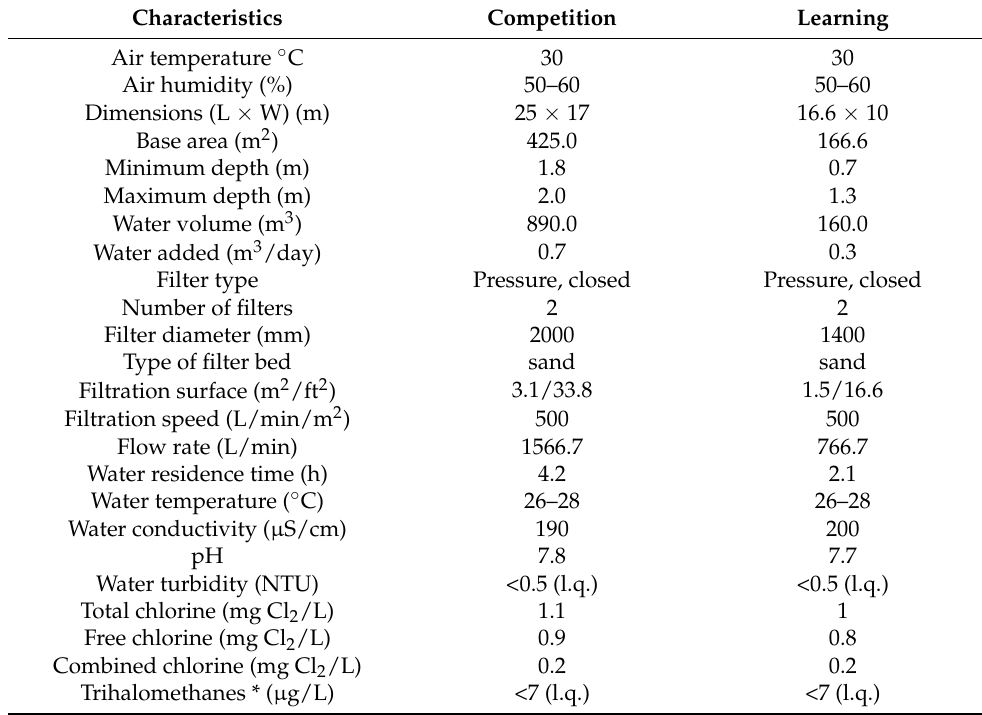
Table 1. Swimming-pool’s characteristics and mean values of some water parameters (Source: Bragança